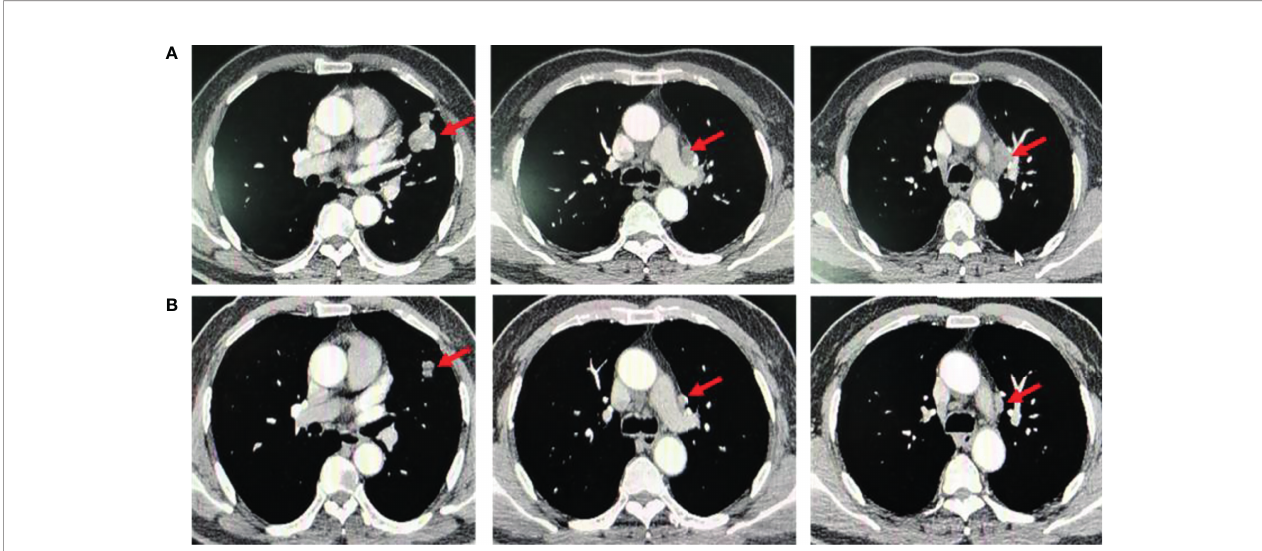
FIGURE 2 | Disease status before and after neoadjuvant almonertinib therapy. Computed tomography chest (CT) scan showed (A) left lingual lobe occupancy with a size of 4.0 × 3.8 × 2.3 cm, and subaortic lymph nodes before aumolertinib treatment. (B) Left lingual lobe occupancy with a size of 1.2 × 1 × 1.5 cm, and subaortic lymph nodes after aumolertinib